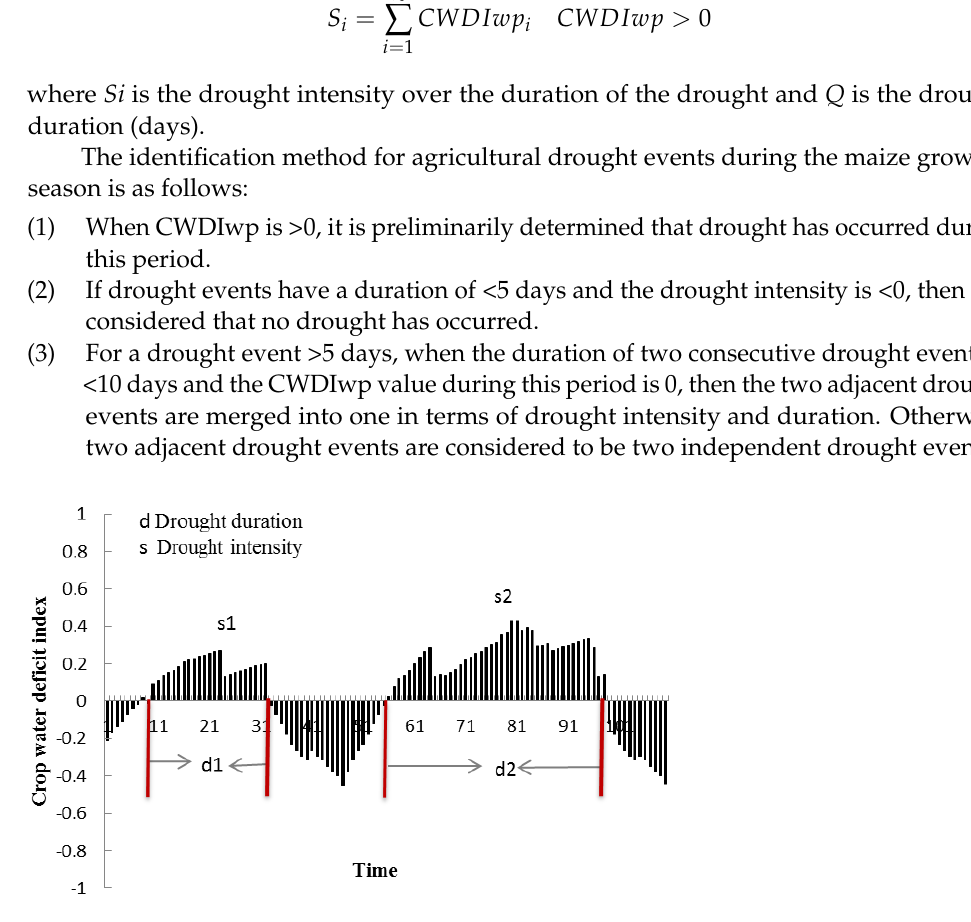
Figure 2. Schematic diagram of the run theory. Table 1. Threshold indicator of agricultural drought event.